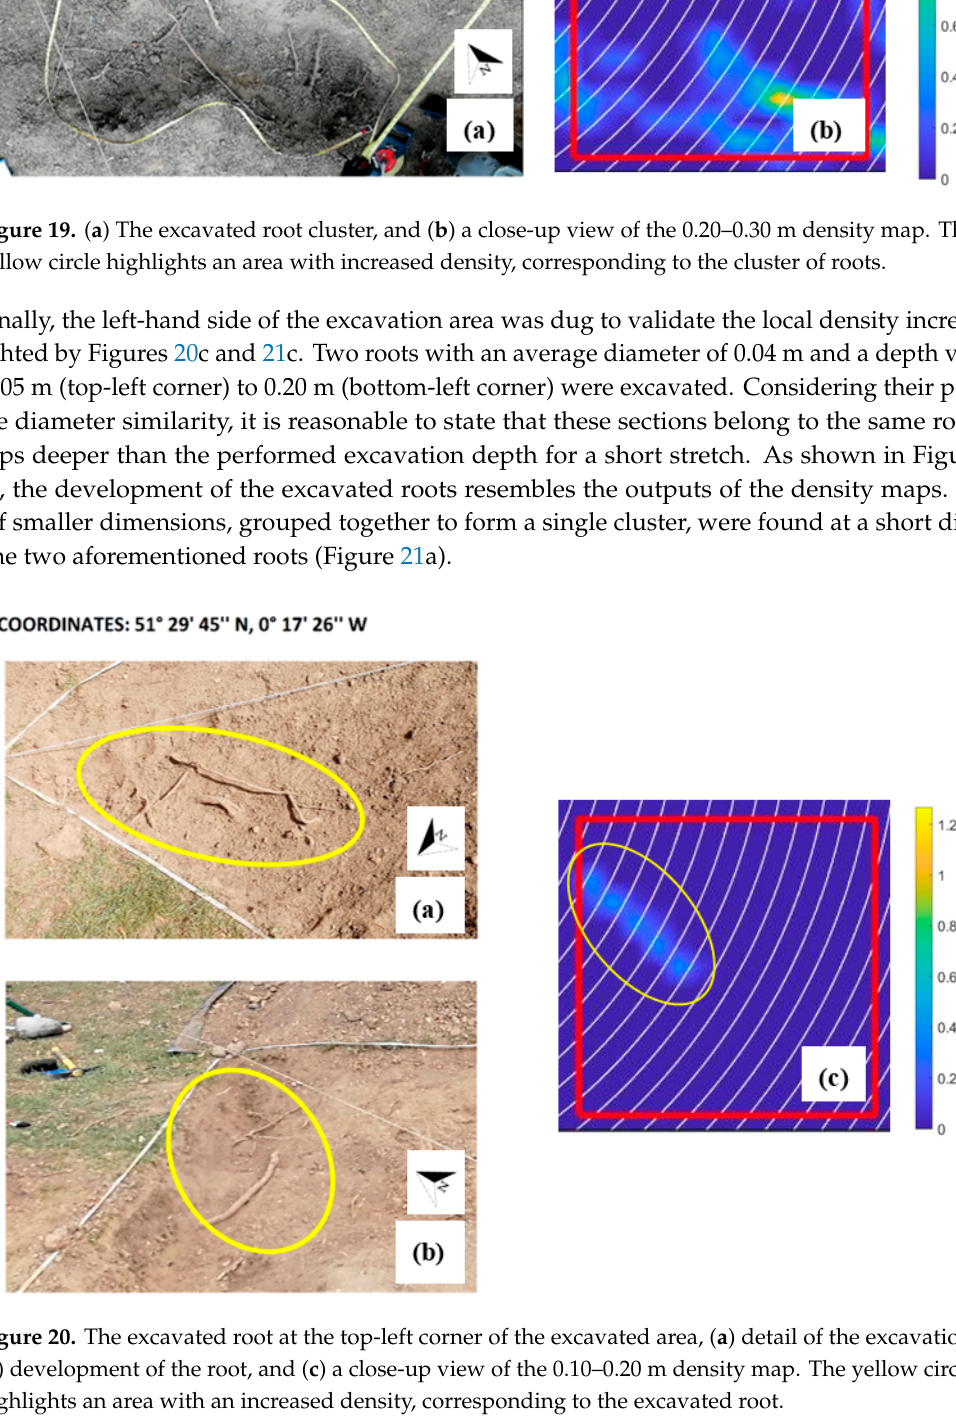
Figure 20. The excavated root at the top-left corner of the excavated area, ( a ) detail of the excavation, ( b ) development of the root, and ( c ) a close-up view of the 0.10–0.20 m density map. The yellow circle highlights an area with an increased density, corresponding to the excavated root.